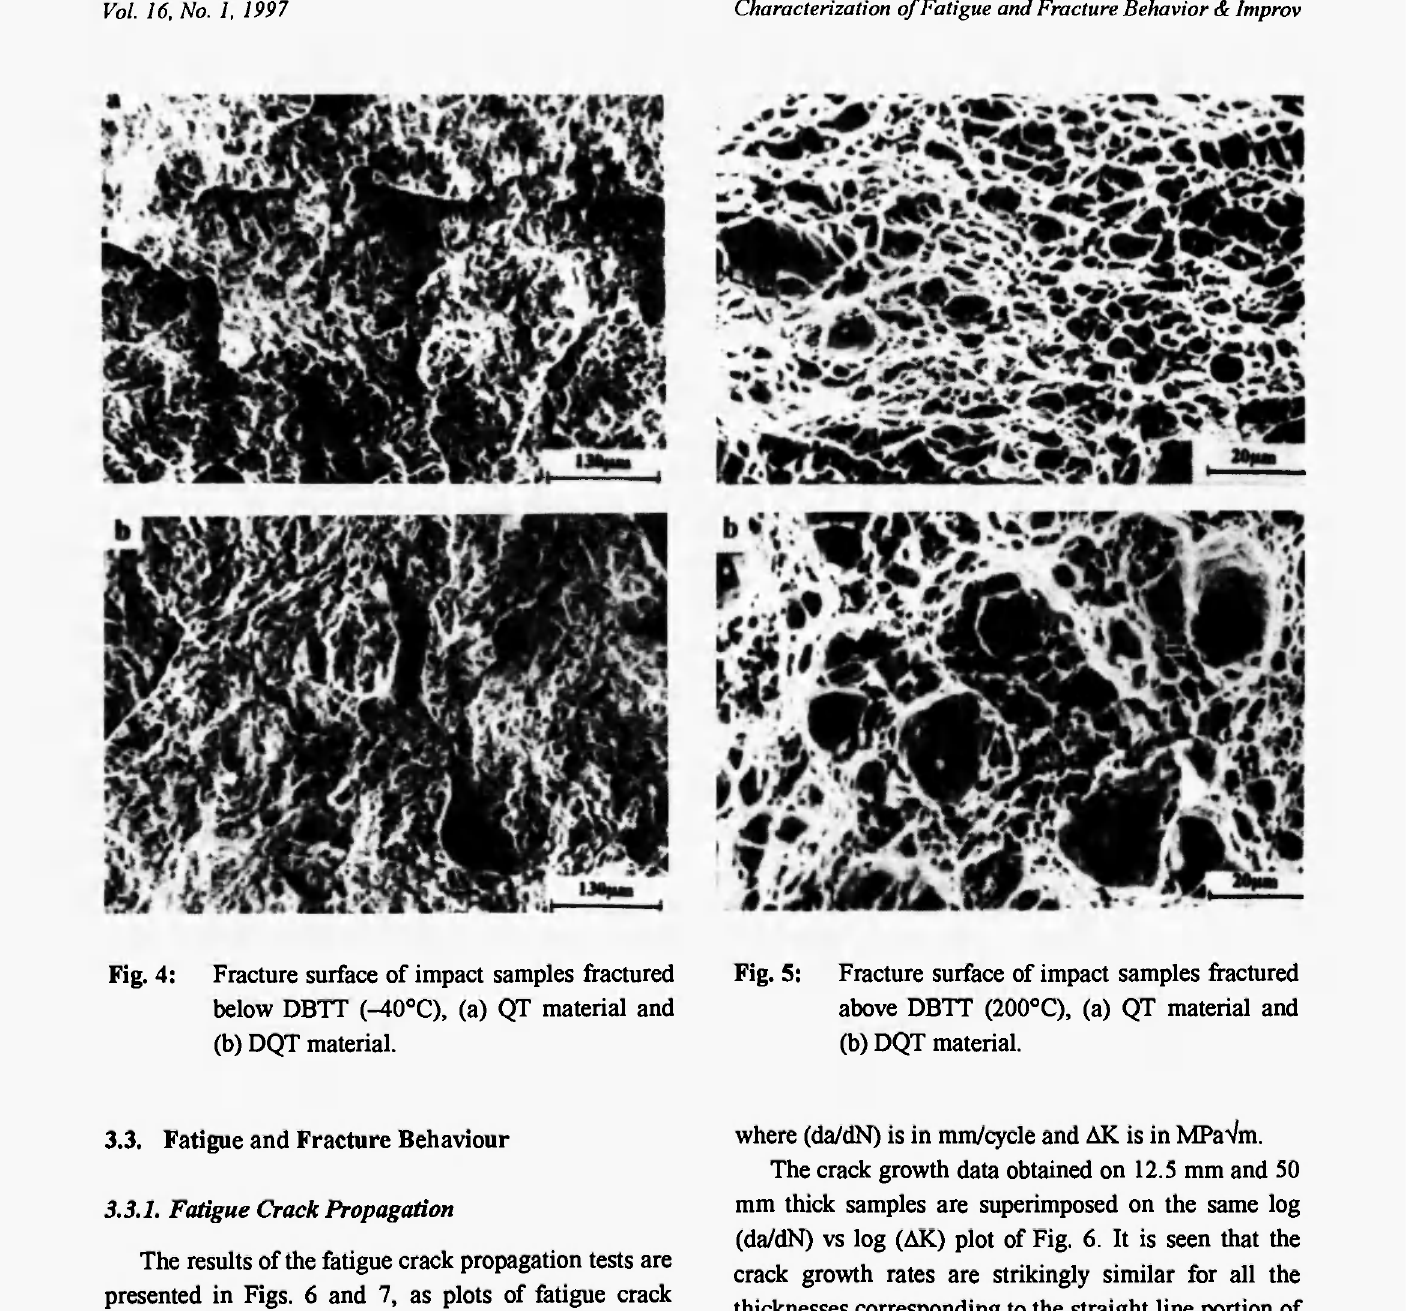
Fig. 4: Fracture surface of impact samples fractured below DBTT (-40°C), (a) QT material and (b) DQT material.